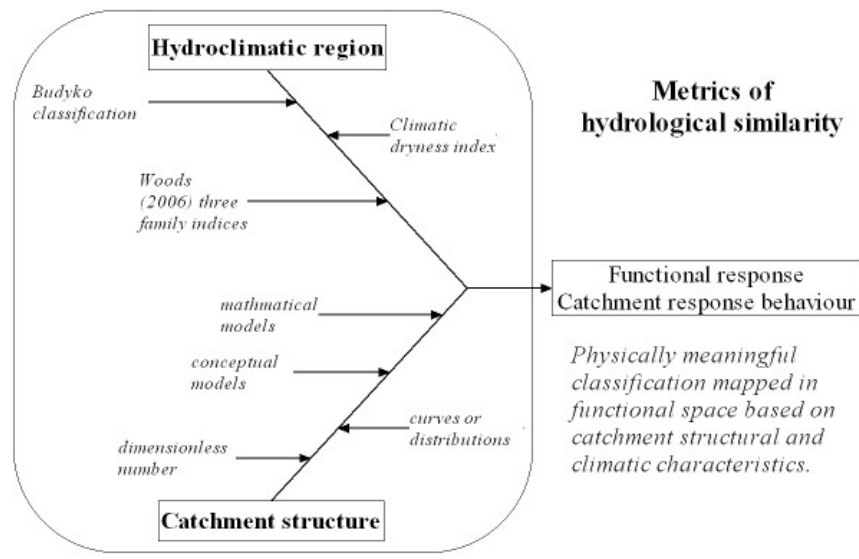
Fig. 2. The general framework of hydrological similarity and catchment classification based on Wagnener et al.